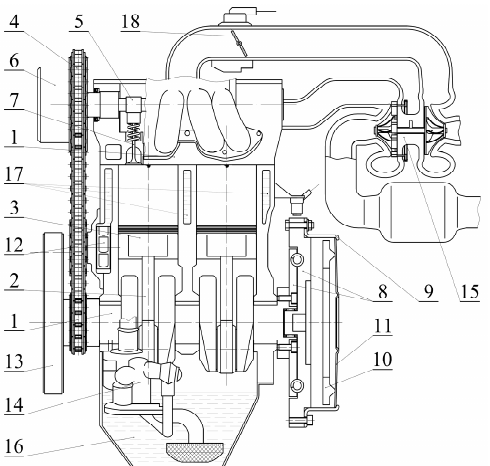
Figure 2. Main parts of the combustion engine influencing its overall inertia: 1 – crankshaft, 2 – connecting rod, 3 – piston, 4 – valve-train chain, 5 – camshaft, 6 – variable valve timing, 7 – valve, 8 – dual mass fly-wheel, 9 – clutch cover, 10 – pressure plate, 11 – diaphragm spring, 12 – coolant pump, 13 – accessories pulley, 14 – oil pump, 15 – turbocharger, 16 – oil, 17 – coolant, and 18 – throttle valve.